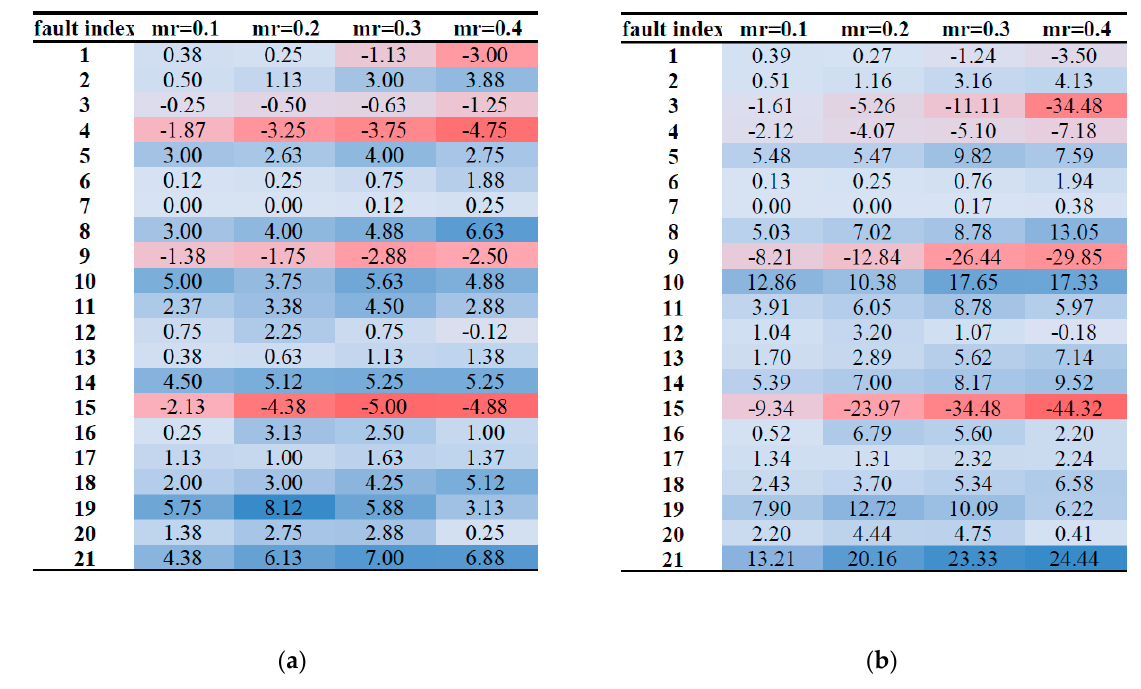
Figure 7. Details of LACC improvement by DRPF under the soft voting rule. ( a ) Absolute change value of LACC, ( b ) relative change value of LACC (%).